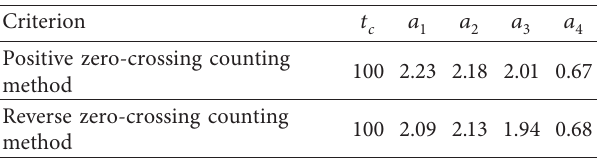
Table 2: Statistical results of freak waves characteristic parameters based on the upper and lower zero-point method when t c � 100s.